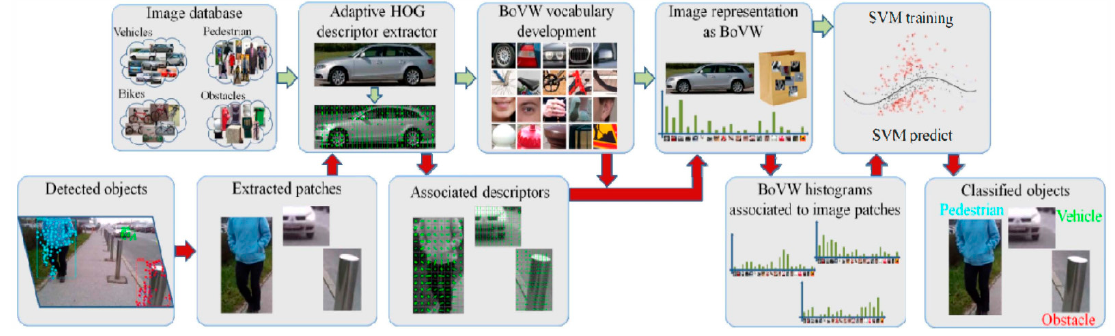
Figure 21. The process of detection and recognition algorithm [43].